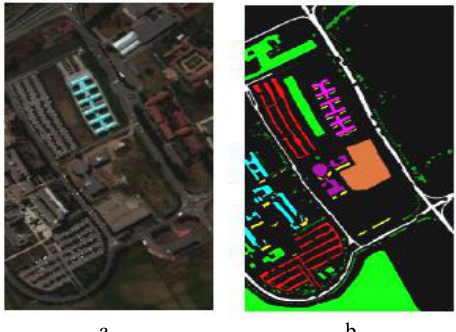
Figure 6 . Pavia dataset. a is the pseudo color image, b is the ground truth map.